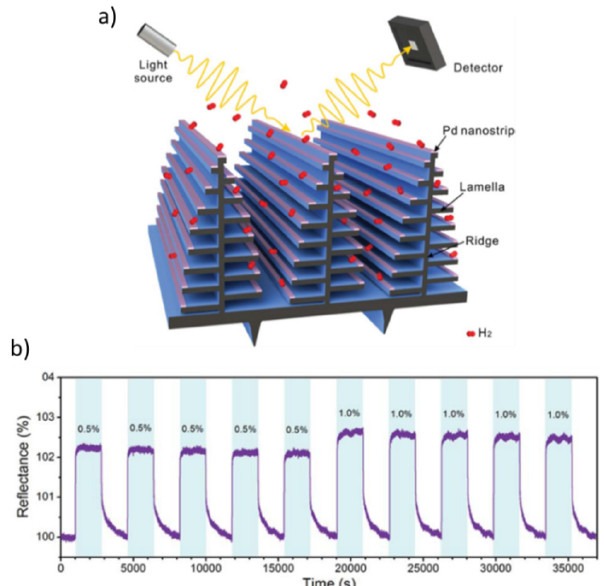
Figure 10. ( a ) Schematic illustration of an optical H 2 sensor based on 3D photonic structures consist- ing of Morpho butterfly wings and Pd nanostrips. ( b ) Five cycles during which the Morpho butterfly wing structure is exposed to either 0.5 or 1.0% H 2 and a H 2 -free gas. Reproduced from [91], with